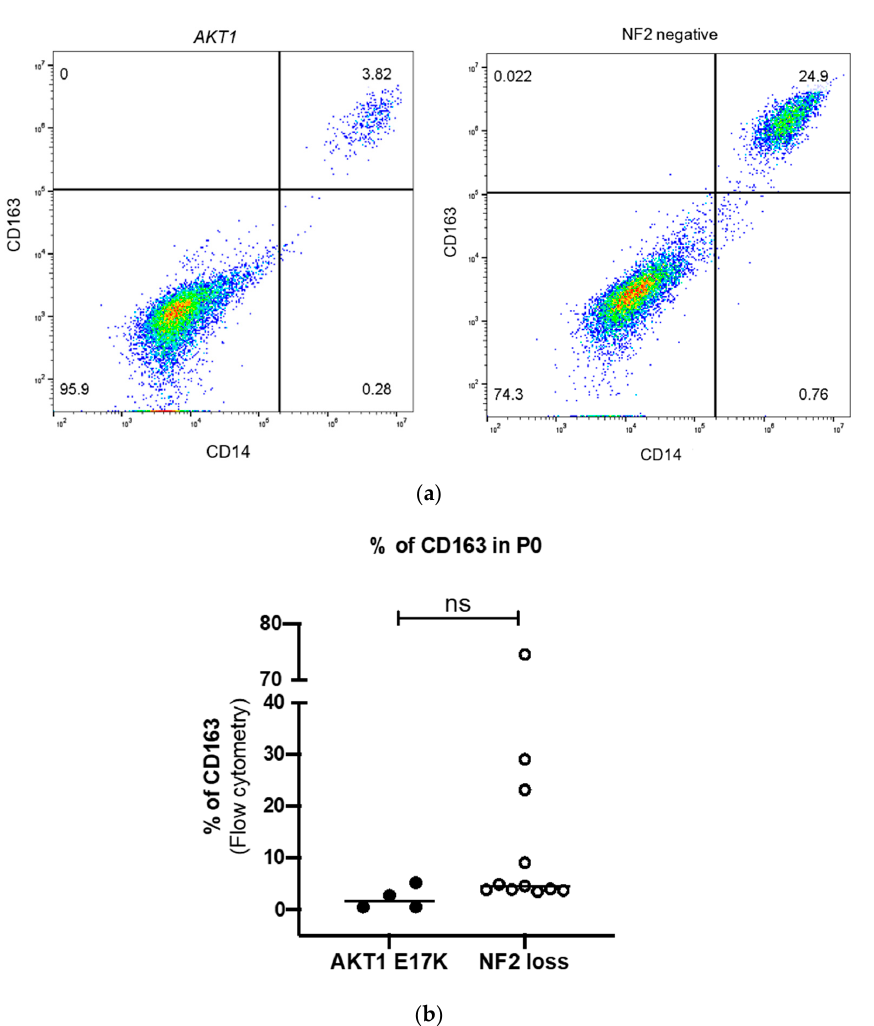
Figure 2. ( a ) Representative flow cytometry dot plot for CD14-PerCP-Cy5.5 + (FL3) CD163-AF647 + (FL4) cells in AKT1 E17K and NF2-negative primary cell culture at Passage 0 (p0) ( b ) Comparison of the CD45 + HLA-DR + CD14 + CD163 + M2 macrophages in AKT1 E17K mutants ( n = 4) and WHO grade